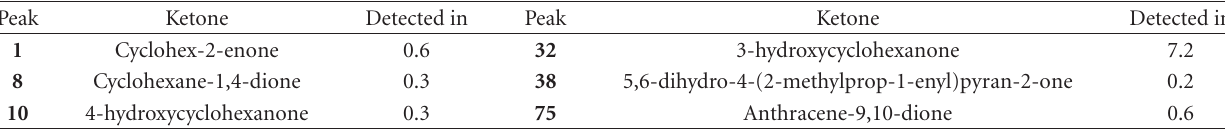
Table 9: Ketones detected in the products from ASF ODVR .